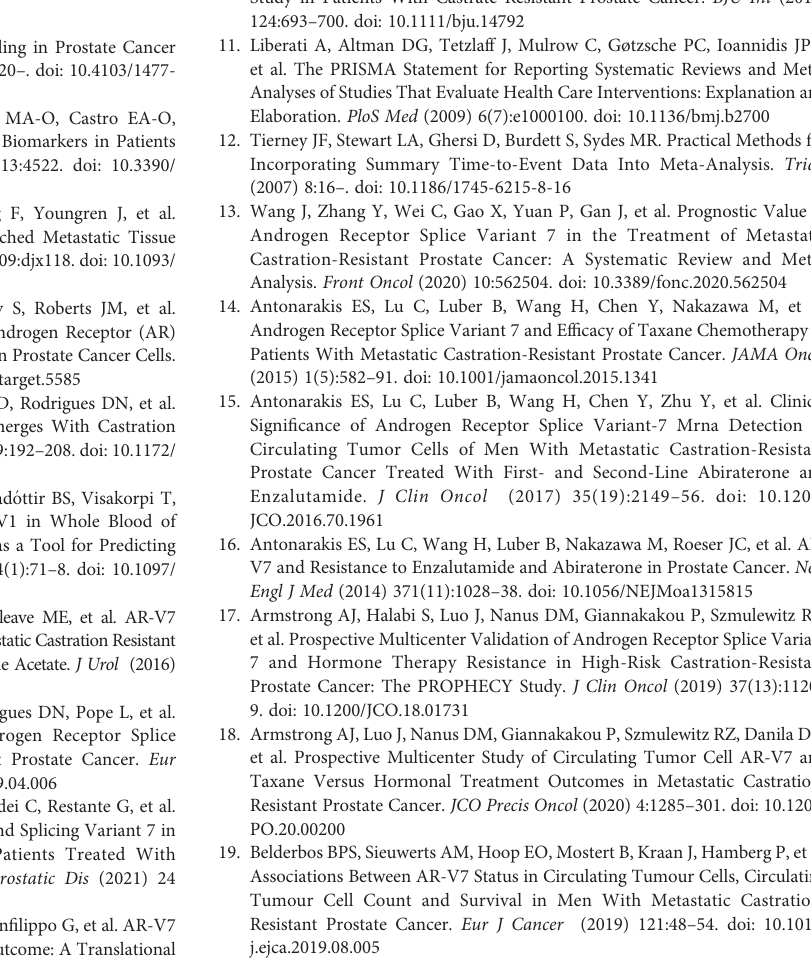
Supplementary Table 2 | Quality assessment of included studies based on adapted NOS scales. Supplementary Table 3 | Sensitivity analysis of subgroups with more than 6 studies.